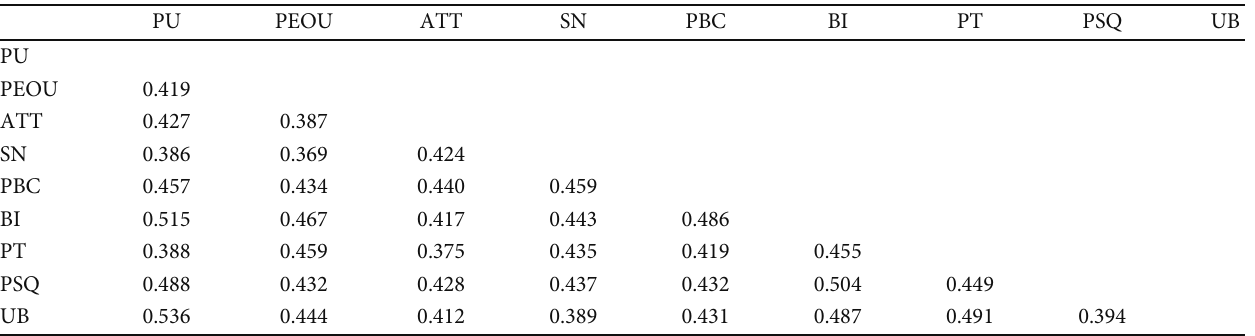
Table 3: HTMT ratio.